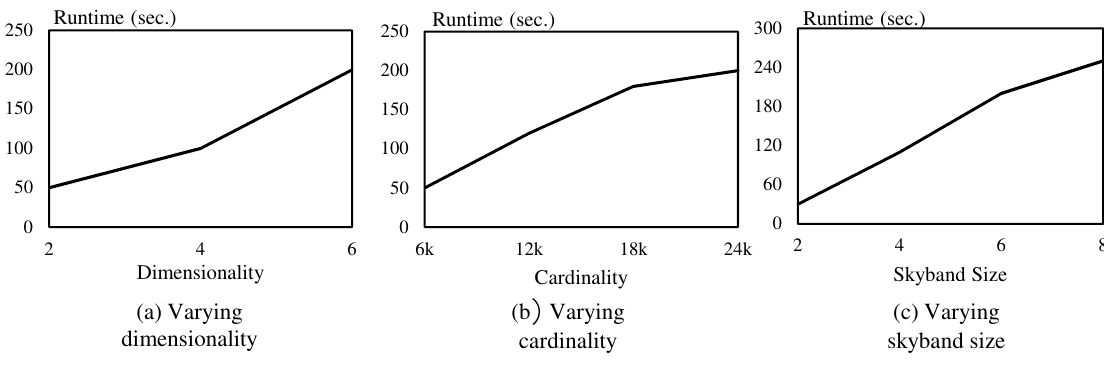
Figure 11. Experiments on the FUEL